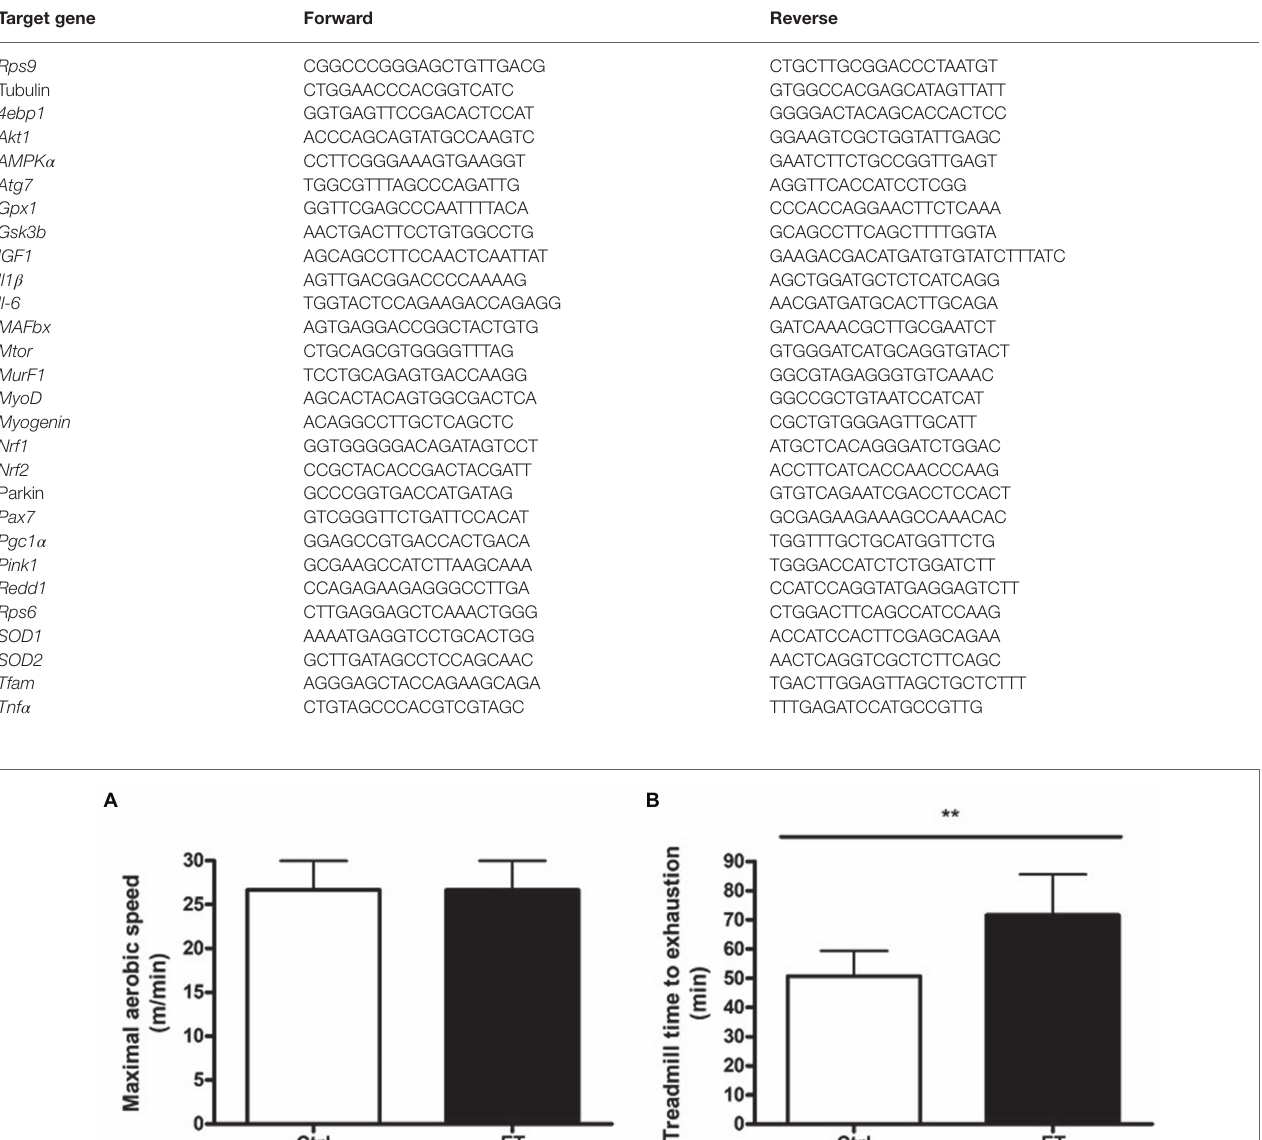
TABLE 2 | Primers used for the qPCR assays.